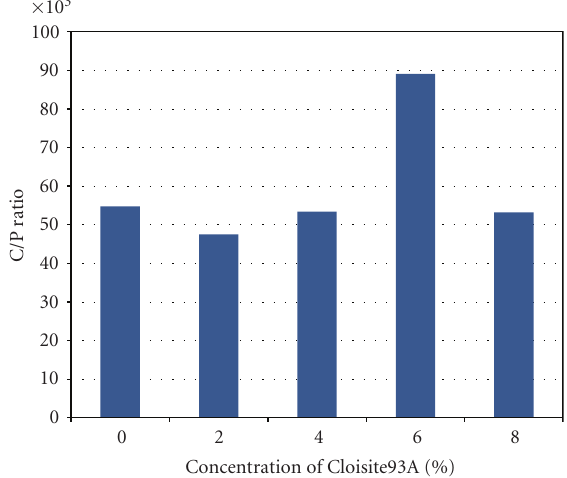
Figure 5: Protonconductivity values of sulfonated PVA membranes with varying concentrations of Cloisite 93A.